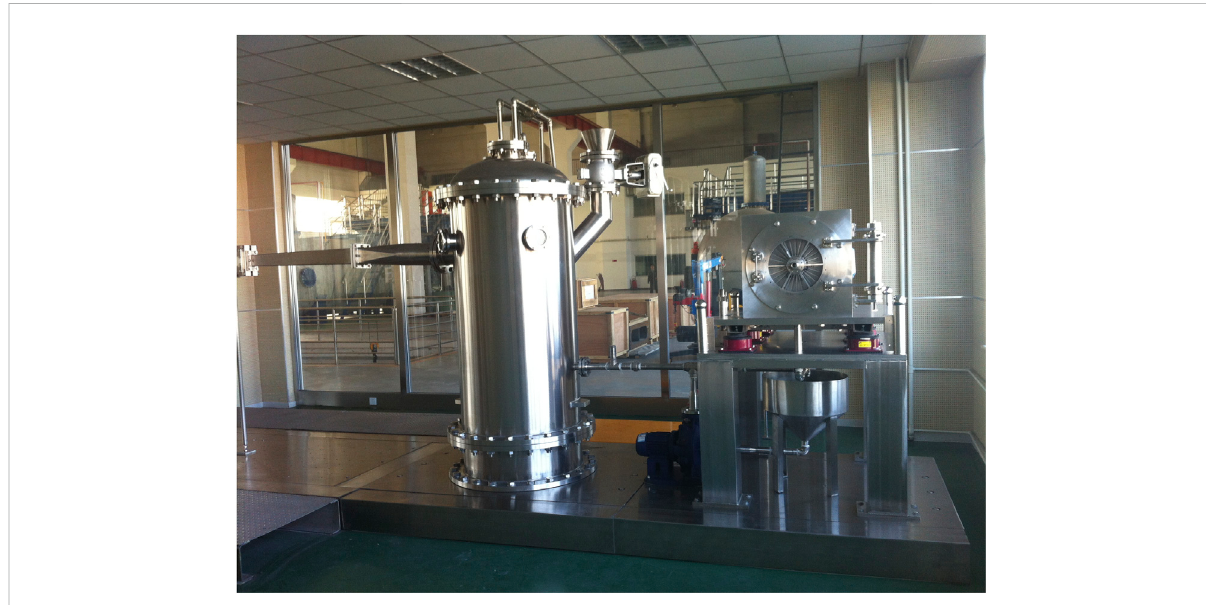
FIGURE 7 PhotographofthehydraulicmachineryabrasiontestingsystemattheChinaInstituteofWaterResourcesandHydropower Research(Hydraulic Machinery, 2021).